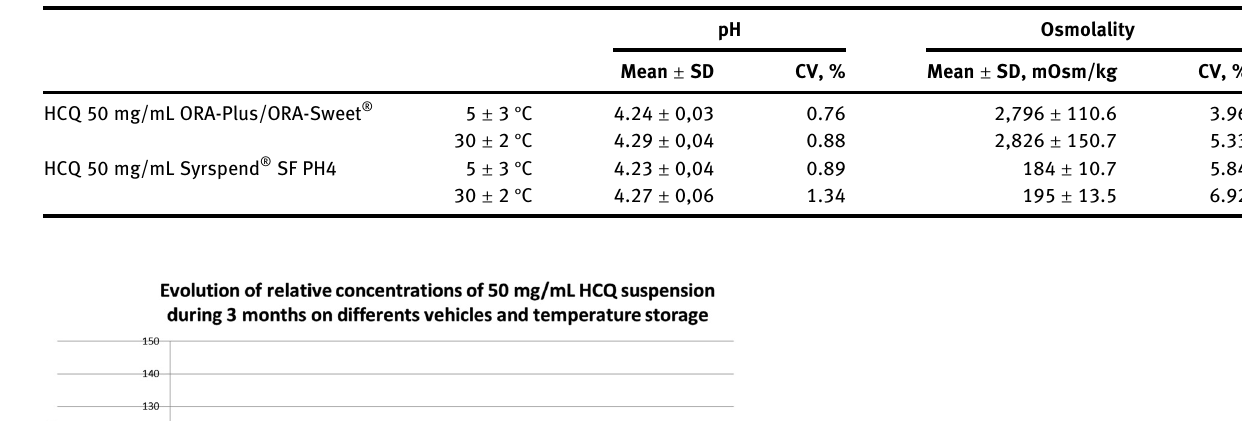
Figure 5: Representation of relative HCQ concentration during 90 days of stability study of HCQ suspension (50 mg/mL), in two different oral vehicles suspension ORA (OraSweet ® /OraPlus ® ) and SYR (Syrspend ® SF PH4), at both ICH conditions 5 and 30 ° C. (Triangle: ORA HCQ at 30 °